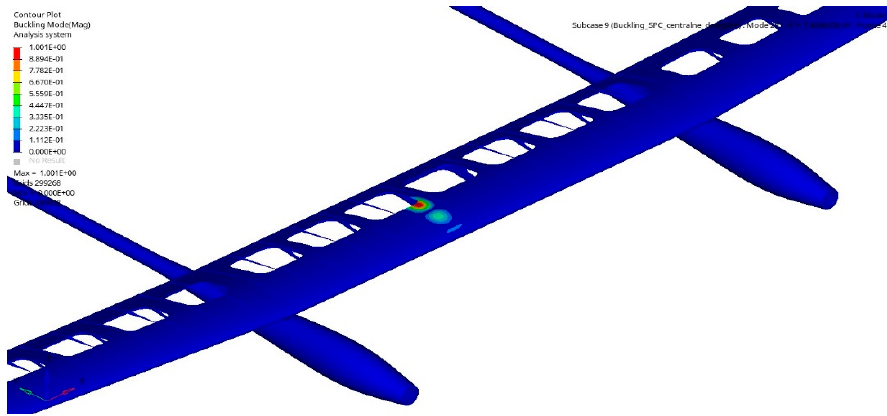
Figure 19. Example of stability lose in the central part of the UAV.